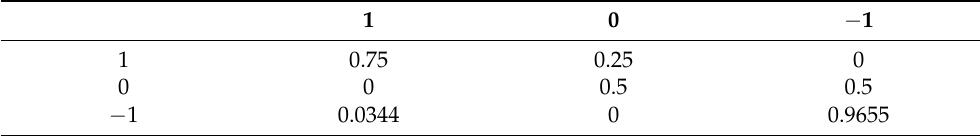
Table 4. Quarterly transition matrix of the companies from the sample. 01/03/2014 to 01/03/2020.